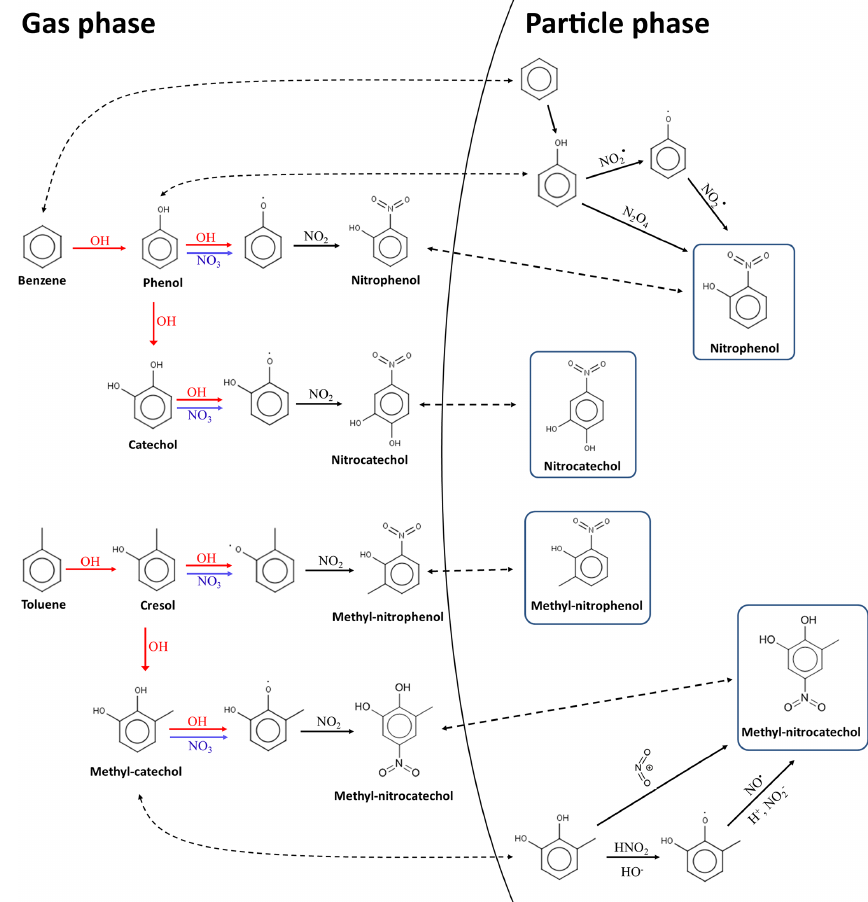
Figure 1. Schematic presentation of NAC secondary formation pathways via the oxidation of benzene, toluene, phenol, and methycatechol in the gas phase and particle phase (Jenkin et al., 2003; Frka et al., 2016; Vione et al., 2001, 2004; Vidovic et al.,